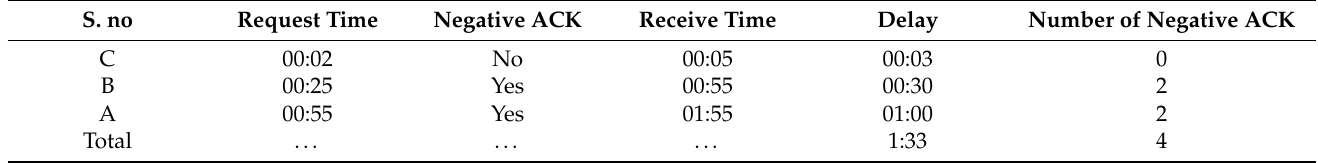
Table 2. Spoofing Attack through Radio